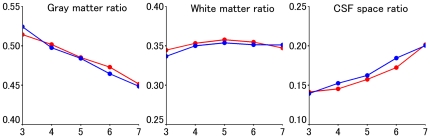
Relationship between gray matter ratio, white matter ratio, and CSF space ratio and age group, moving from left to right.Blue lines and markers indicate men, and red lines and markers indicate women. In each graph, the vertical axis indicates regional gray matter volume (no units), and the horizontal axis refers to subjects in the third (aged 20–29), fourth (aged 30–39), fifth (aged 40–49), sixth (aged 50–59), and seventh (aged 60–69) decades of life, respectively, moving from left to right.